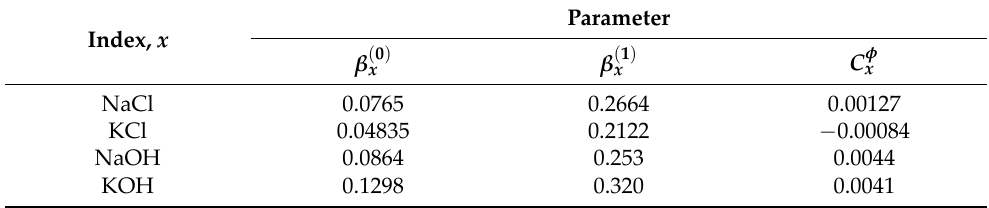
Table A2. Pitzer model binary parameters for Equations (23) and (24). [69], Table 2,